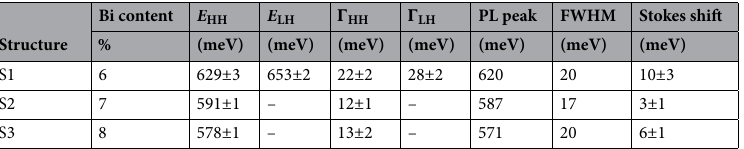
Table 1. Extracted parameters from the PR spectra using Eq. (1) presented as a function of the Bi content in a quantum well. The PL peak energy and its FWHM is derived from the Gaussian fit to the PL emission band 2 measured at P exc = 1.13 Wcm −